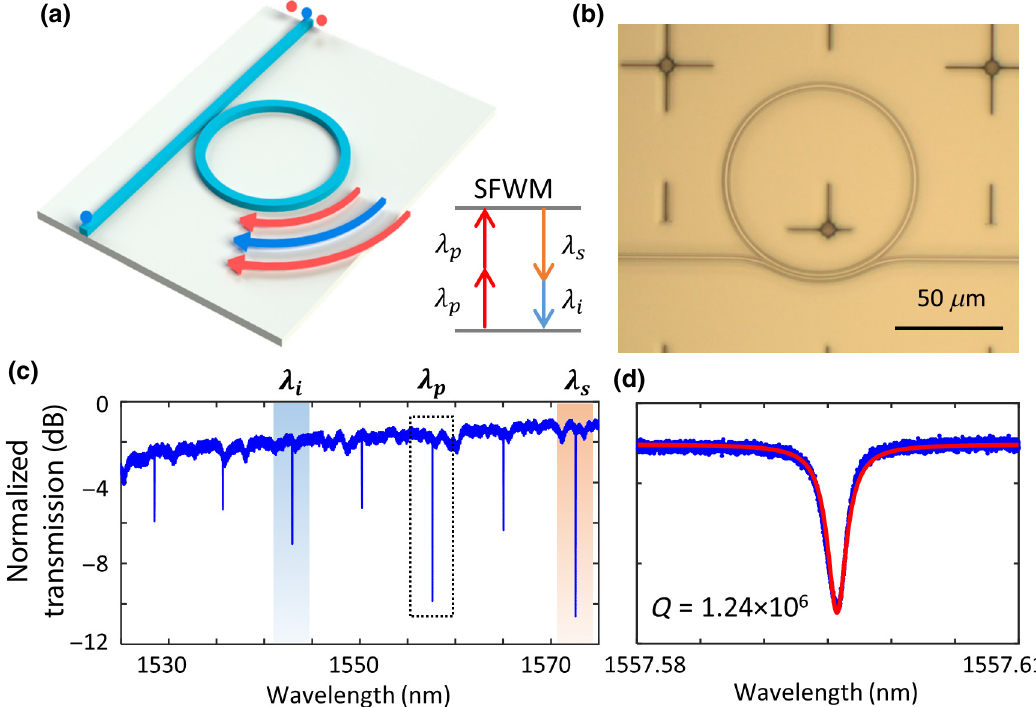
FIG. 2. (a) A schematic illustration of entangled-photon-pair generation from a photonic microring resonator. Pump photons ( λ p ) are coupled into the waveguide bus and ring and are converted into signal ( λ s ) and idler ( λ i ) photons via spontaneous four-wave mixing (SFWM). (b) An optical-microscope image of a representative AlGaAsOI ring-resonator pulley with a 30- μ m radius. (c) The resonator transmission spectrum with signal (1572-nm) and idler (1542-nm) wavelengths two free-spectral ranges away from the pump (1557-nm) resonance. (d) The resonator transmission spectrum of the pump resonance (blue trace). A Q = 1.24 × 10 6 is determined from the superimposed Lorentzian fit (red